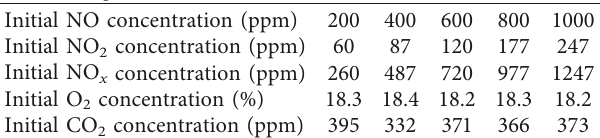
Figure 5: Changes of NO x concentrations at inlet and outlet ports of the RPB reactor (a) and NO x removal efficiencies (b) with inlet NO concentrations. Table 2: The initial concentrations of NO, NO 2 , NO x , O 2 , and CO 2 in exhaust